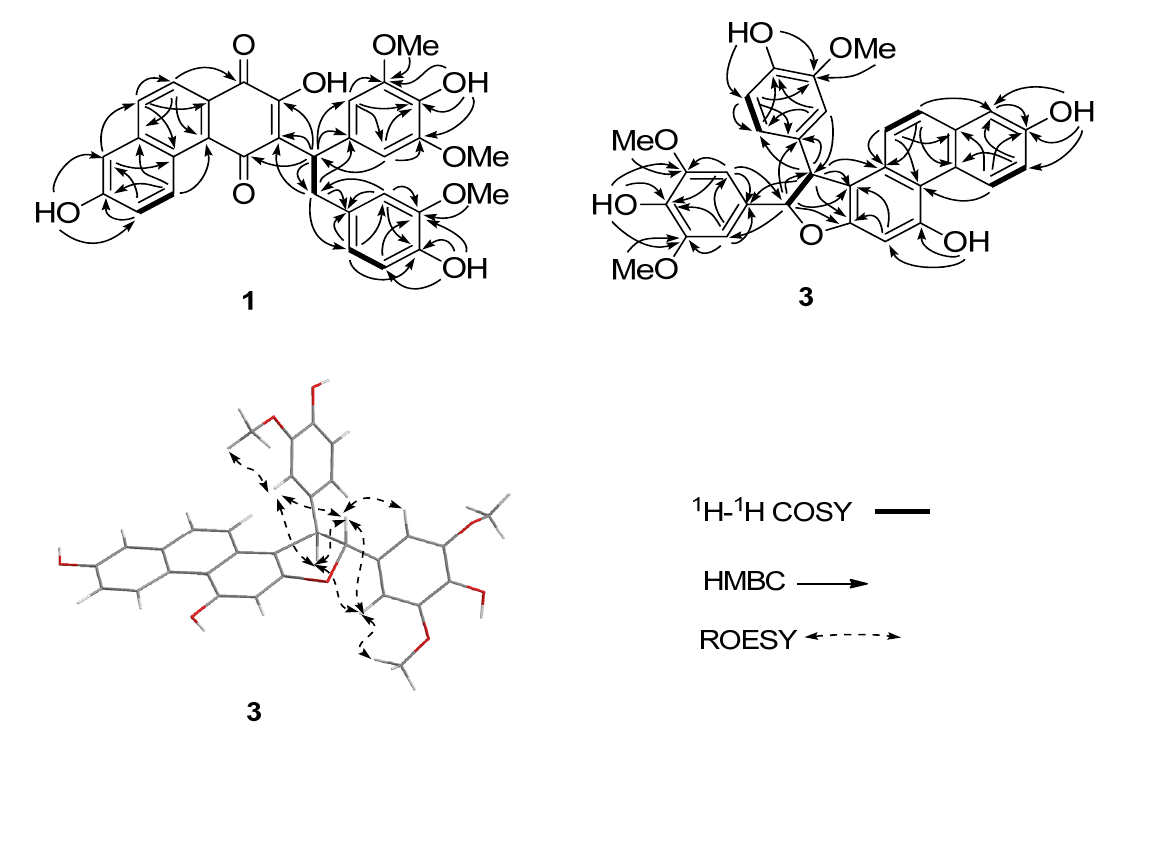
Figure 2. 1 H- 1 H COSY and HMBC correlations of compounds 1 and 3